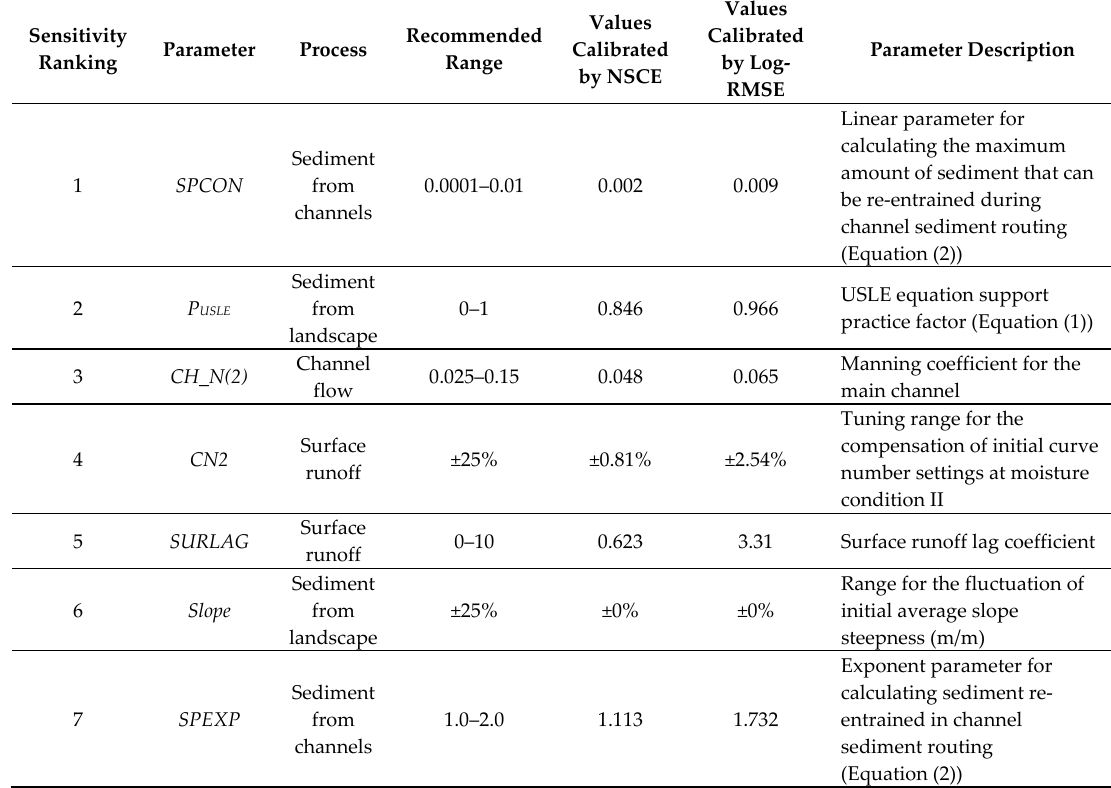
Table 2. Recommended ranges and calibration results of the seven most sensitive parameters for the simulation of sediment yields in sediment and water routing processes of the Soil and Water Assessment Tool